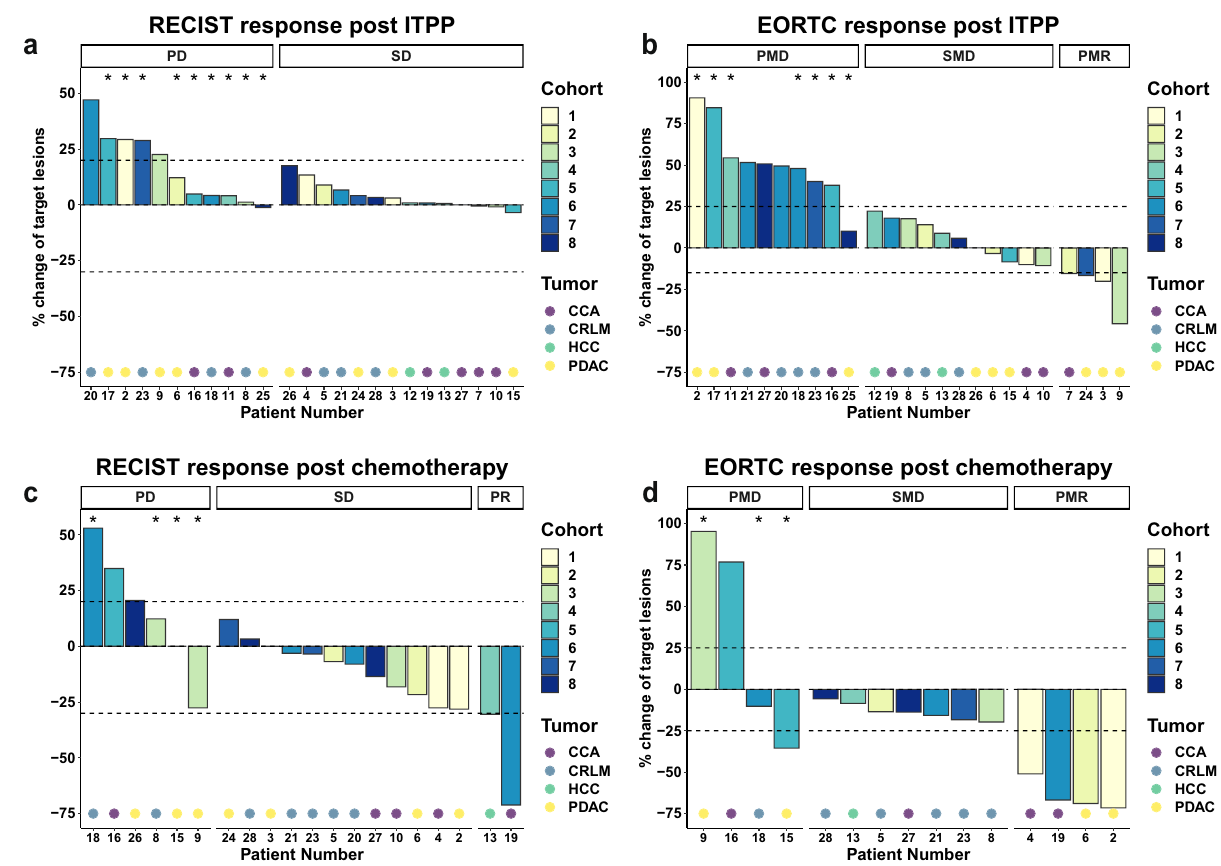
Fig. 2 Radiological responses post ITPP and chemotherapy. Displayed as waterfall plots of percental changes of either diameter in millimeters for RECIST1.1 criteria or SUV uptake for EORTC criteria. Morphological changes according to RECIST1.1 criteria ( a ) and metabolic changes according to EORTC criteria ( b ) in target lesions after ITPP monotherapy. Morphological changes according to RECIST1.1 criteria ( c ) and metabolic changes according to EORTC criteria ( d ) in target lesions after subsequent chemotherapy. *Indicates the appearance of new (FDG avid)